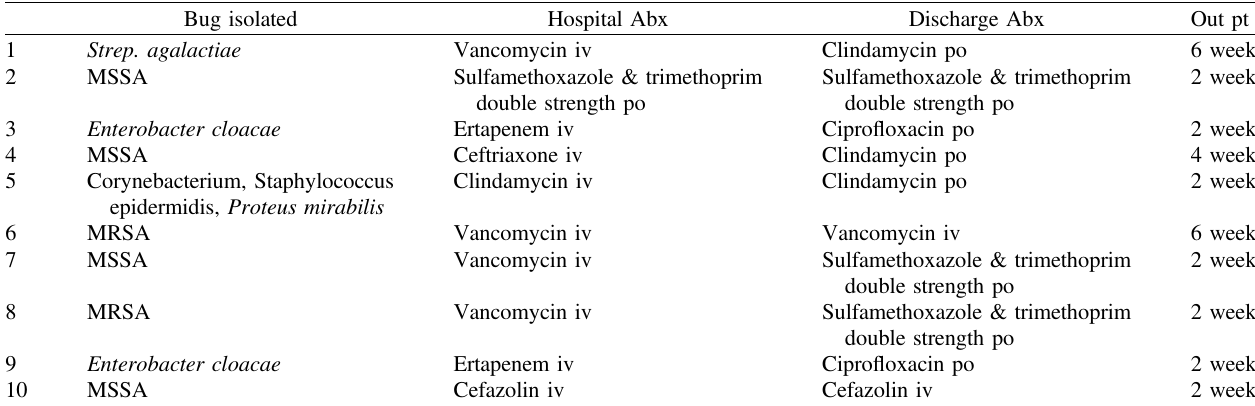
Table 2. Infection isolation and treatment data.